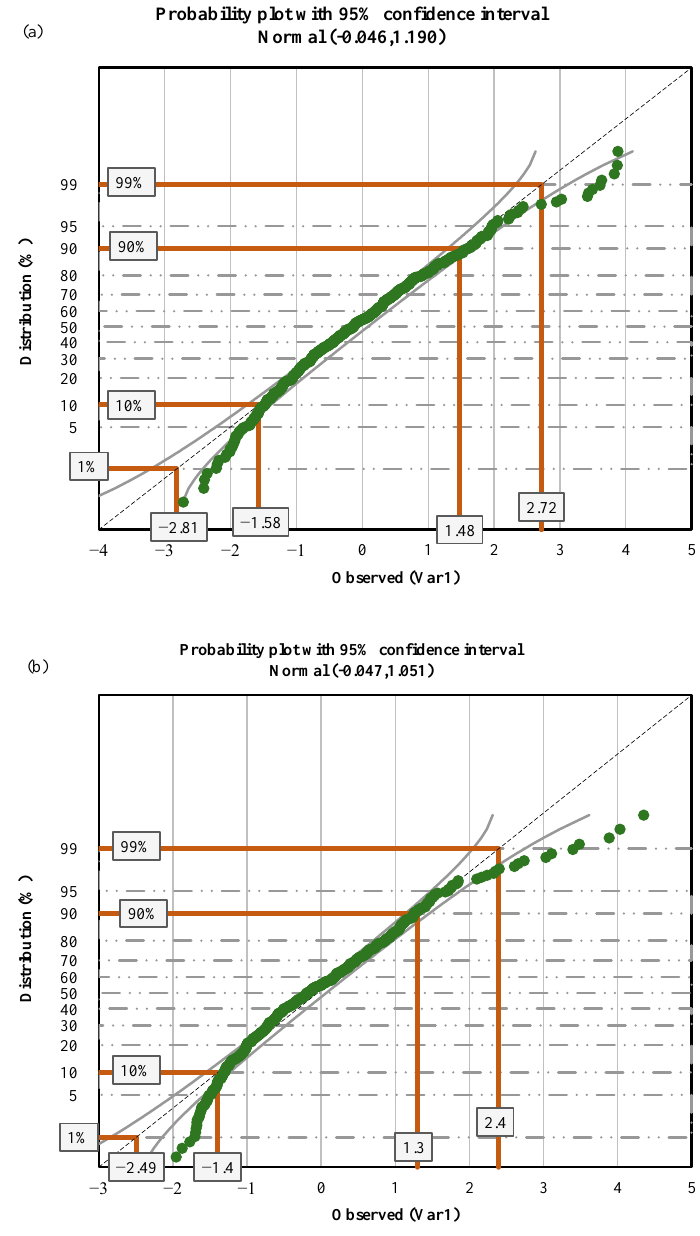
Figure A2. Probability plot with 95% confidence interval for ( a ) SPI 6 and ( b ) SPI 9.